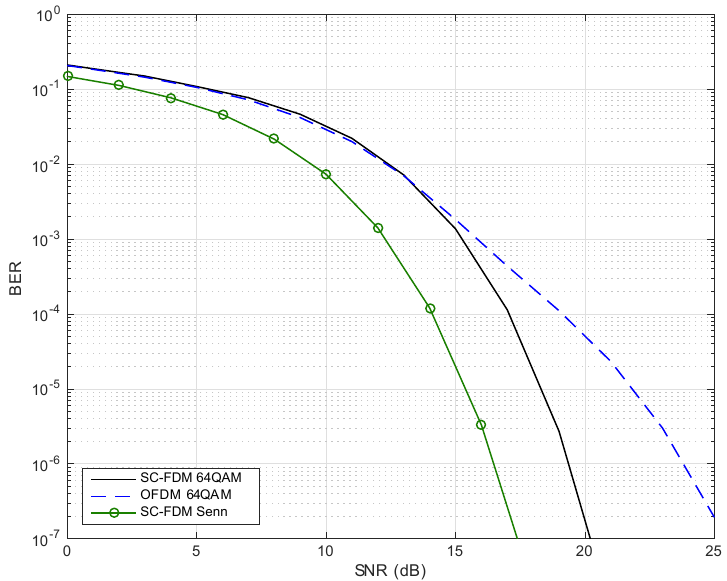
Figure 14. BER vs. SNR comparison of the proposed OFDM and SC-FDM communication systems for the A c with N p = 16, FFT = 256, 64 QAM and BW = 200 kHz. Solid lines represent the results 5 using the proposed channel model and dashed lines represent the results obtained with Senn’s channel